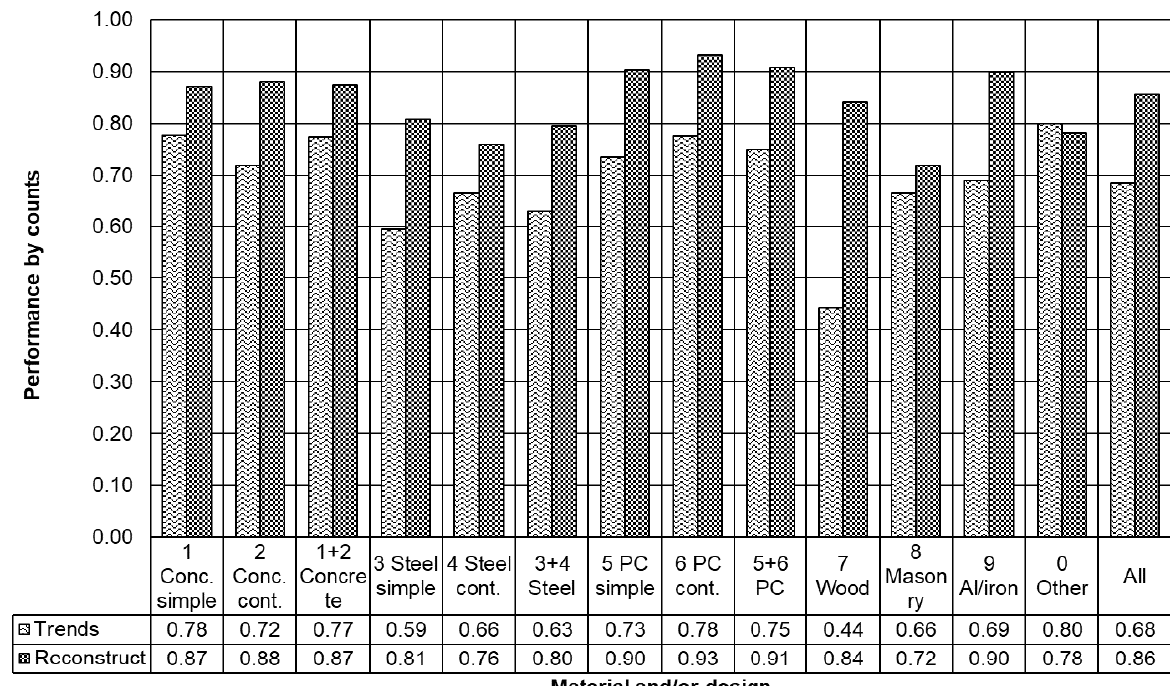
Figure 3. Comparison of deterioration trends and reconstruction performances of bridge counts.